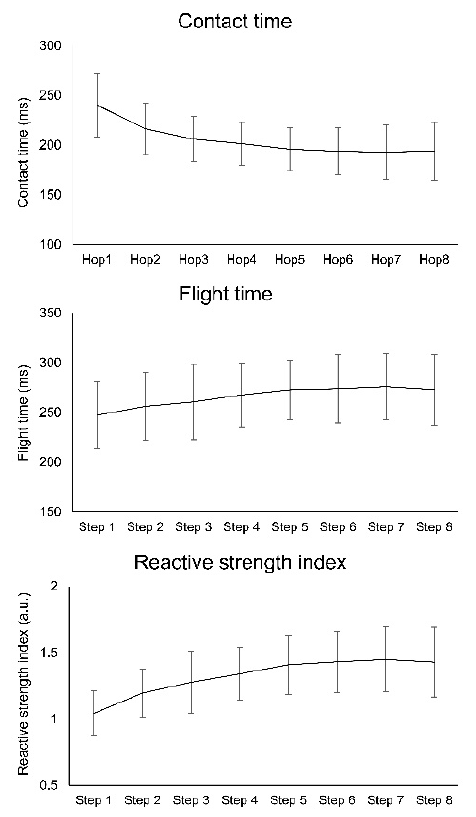
Figure 1. Contact time, flight time, and reactive strength index throughout the 8 hops.